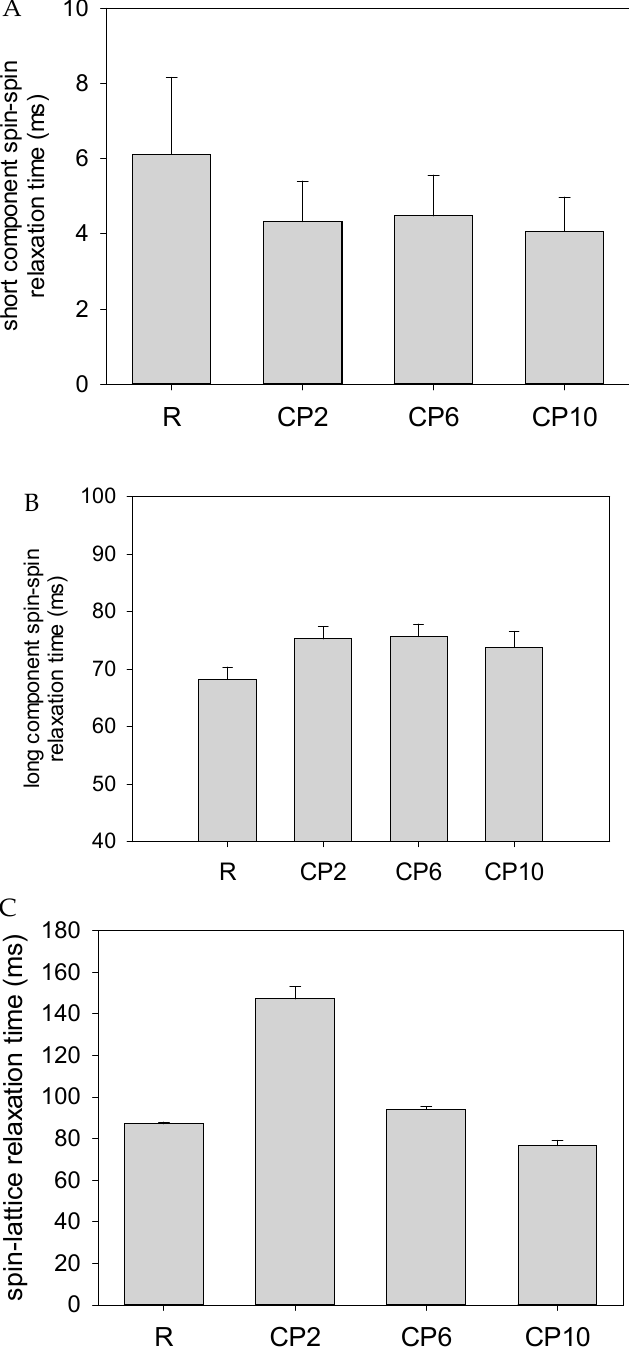
Figure 3. Results of relaxation times. R—reference biscuits; CP2, CP6, and CP10—biscuits with 2%, 6%, and 10% of wheat flour replacement by CP, respectively. ( A )—results of short component spin–spin relaxation time. ( B )—results of long component spin–spin relaxation time. ( C )—results of spin–lattice relaxation time.